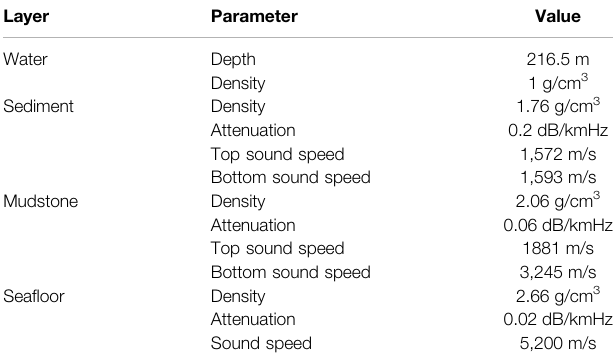
Table 1 | Parameters of the